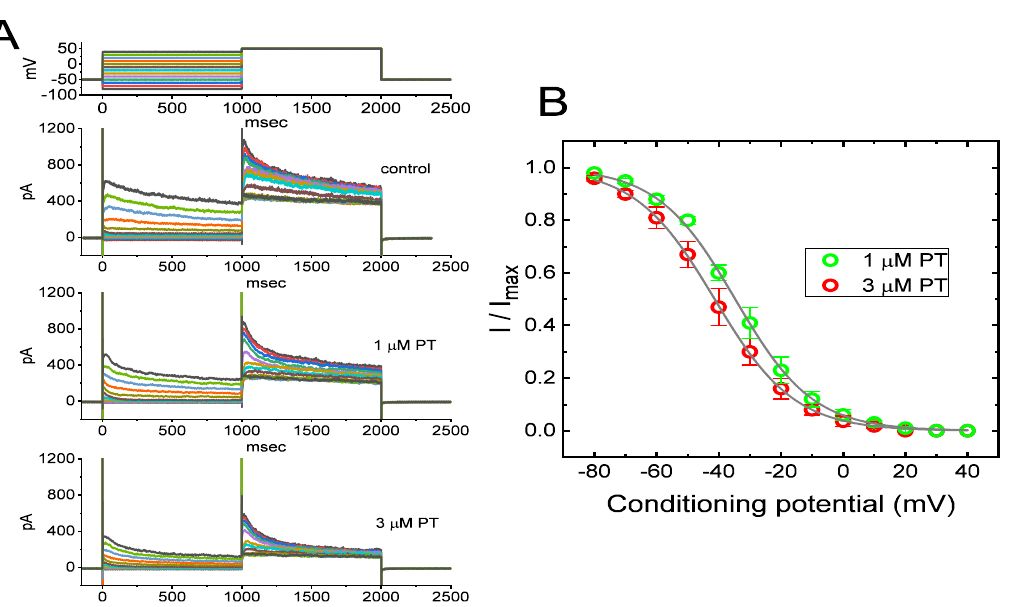
Figure 4. Effect of PT-2385 on the quasi-steady-state inactivation curve of I K(DR) in GH 3 cells. These experiments were undertaken using a 2-step voltage-clamp protocol (as indicated in the inset). ( A ) Representative I K(DR) traces obtained in the control (i.e., PT-2385 was not present, upper image) and in the presence of 1 µ M PT-2385 (middle image) or 3 µ M PT-2385 (lower image). The uppermost part shows the voltage-clamp protocol applied. ( B ) Steady-state inactivation curve of I K(DR) obtained during exposure to 1 µ M PT-2385 ( ) or 3 µ M PT-2385 ( ) (mean ± SEM; n = 8 for each point). The continuous (cid:35) (cid:35) lines overlaid on the data points were well-fitted by the Boltzmann equation detailed in Materials and